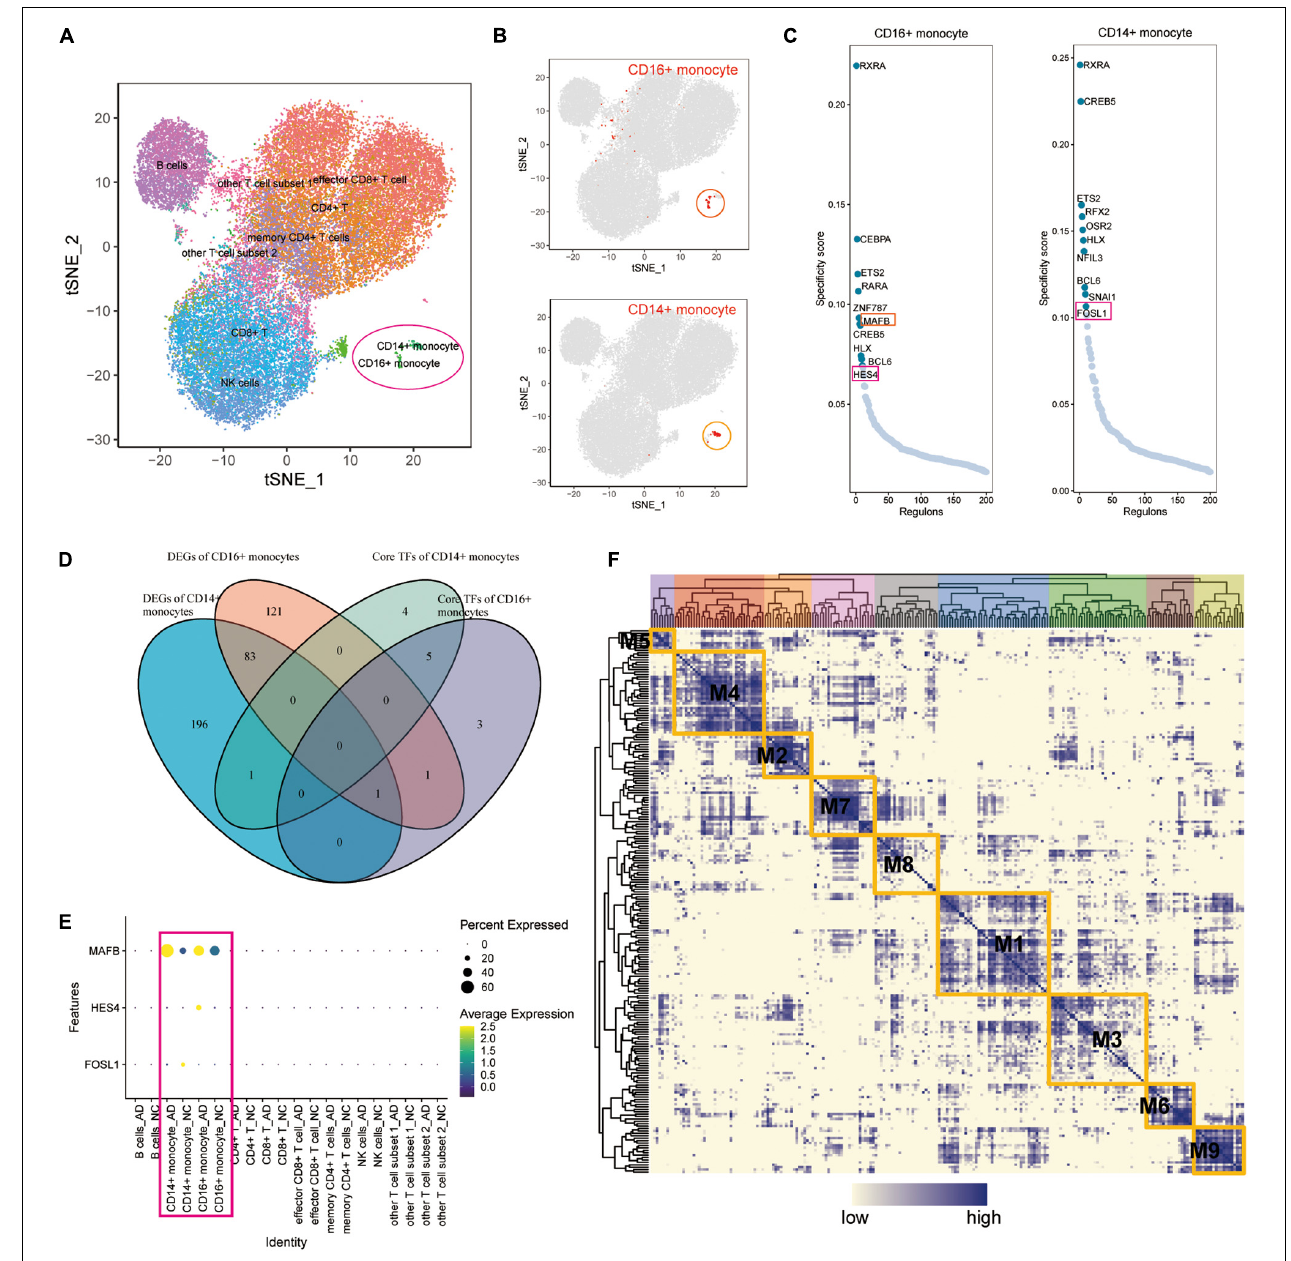
FIGURE 5 | The key transcription factors of monocytes affected by exercise in patients with AD. (A) Unsupervised clustering analysis of the GSE181279 dataset was re-performed using the t-SNE method; (B) The t-SNE plot showing the clustering results of CD14 + and CD16 + monocytes, which suggest that the monocytes are well clustered; (C) The top 10 TFs of CD14 + and CD16 + monocytes based on RSS ranking positions; (D) Venn diagram of intersection analysis of DEGs in CD14 + and CD16 + monocytes from patients with AD and having key TFs in top10 of CD14 + and CD16 + monocytes; (E) Dotted heat map demonstrating the differential expression profile of MAFB , HES4 , and FOSL1 genes in the AD and NC groups; (F) Expression of transcription factors quantified using an entropic strategy and re-clustered in the same way.